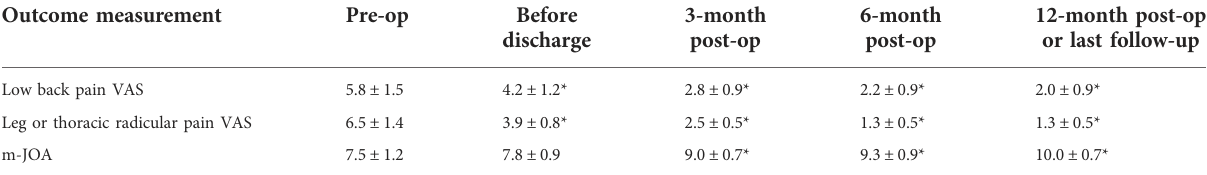
TABLE 4 Mean change of outcome measurement (mean±SD).